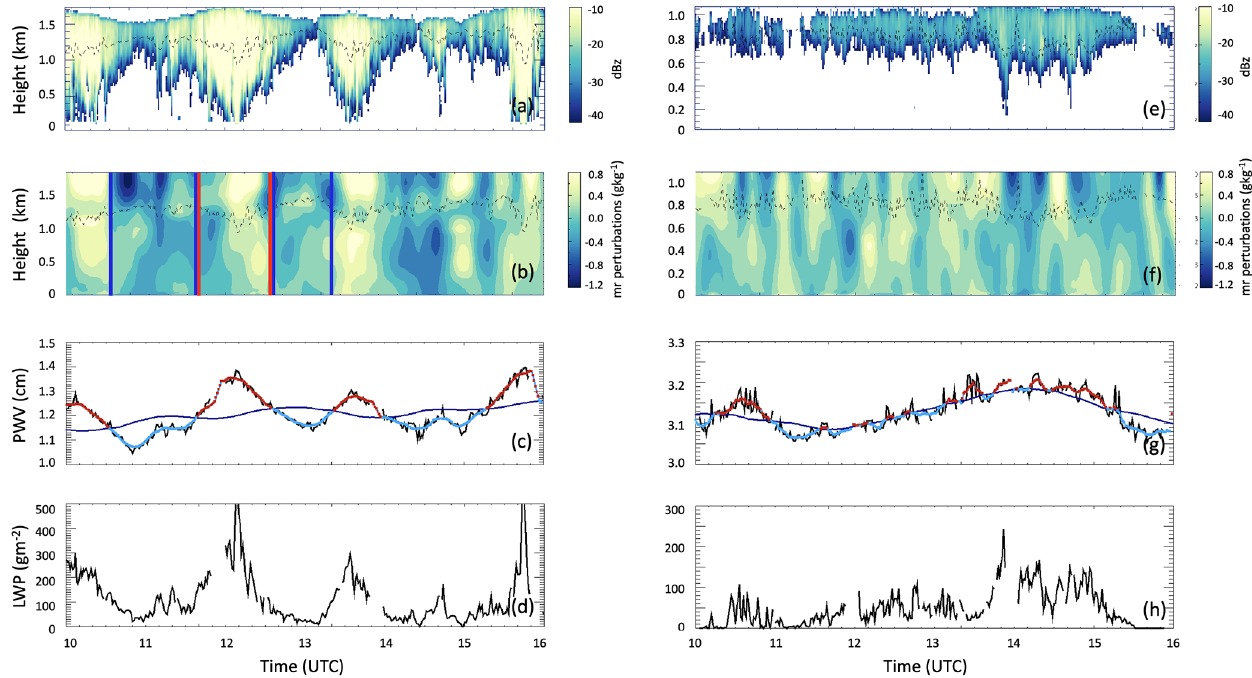
Figure 7. From the top: radar backscatter, mixing ratio (mr) perturbations, PWV, and LWP on 4 April 2019 (a–d) and 8 June 2019 (e–h) . The blue and red vertical bars in (b) represent examples of the beginning and the end of dry (blue) and moist (red) adjacent columns. The dark blue line in (c) is the background state, and red and cyan segments mark moist and dry perturbations.